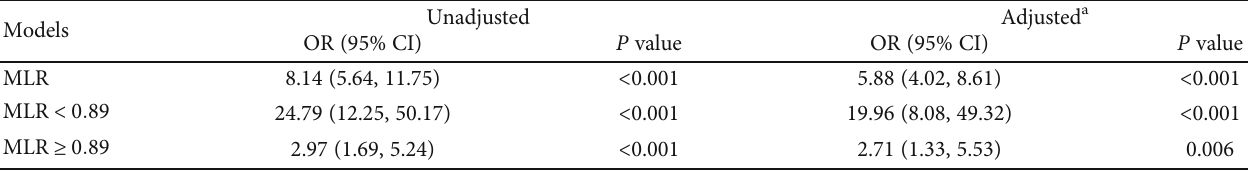
Table 2: Associations of MLR with acute tICH expansion.